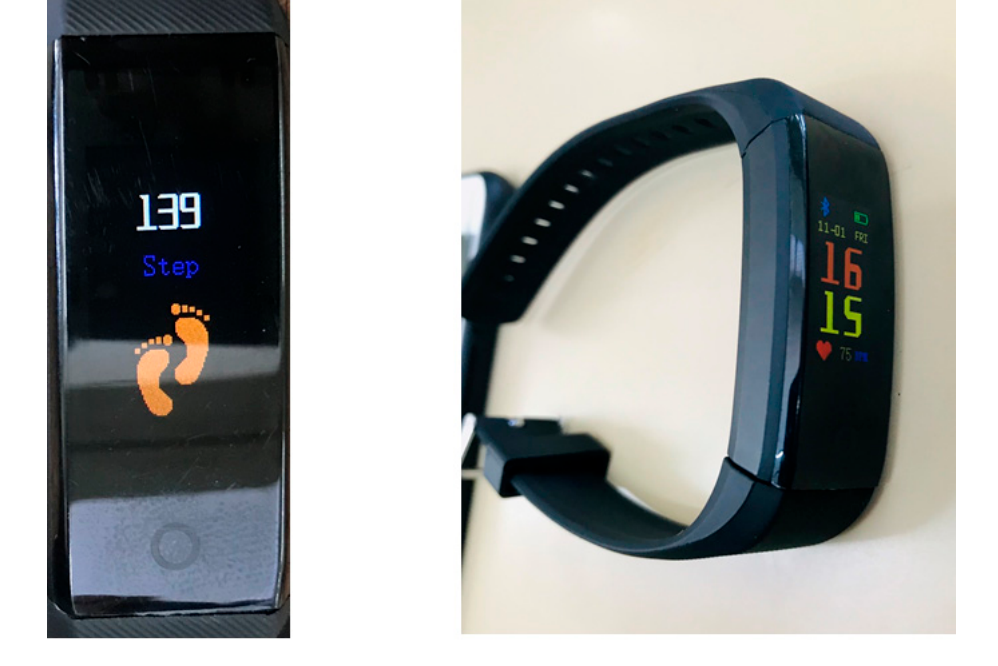
Figure 3. Figure 3. Pedometer.